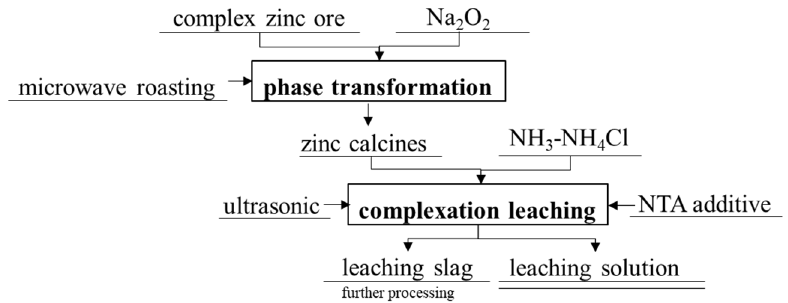
Figure 1. A flow diagram of the experiment.